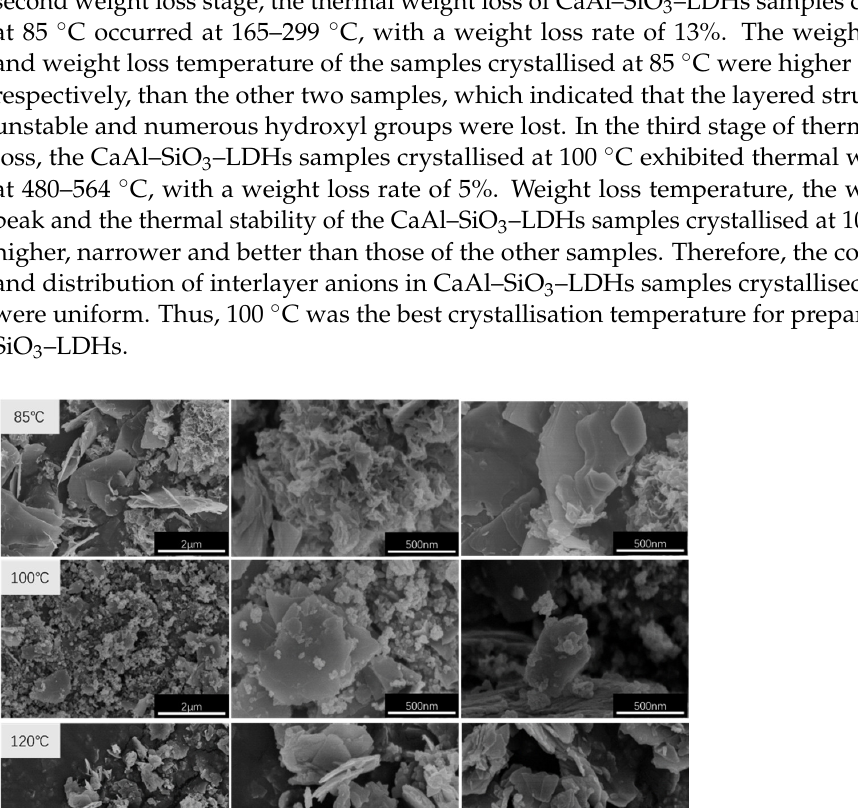
Figure 4. SEM images of CaAl–SiO 3 –LDHs samples prepared at different crystallisation temperatures.